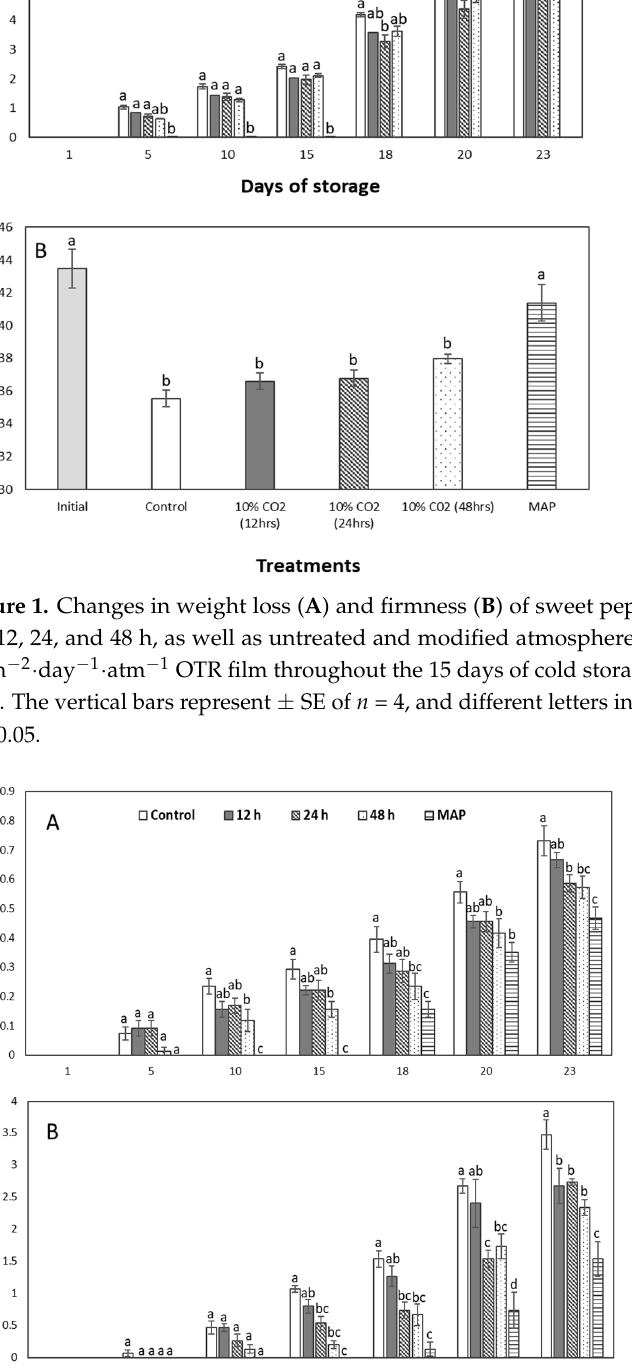
Figure 3. Image of sweet pepper fruits pretreated with 10% CO 2 for 12, 24, and 48 h, as well as untreated and modified atmosphere packaging (MAP) with 50,000 cc ∙ m − 2 ∙ day − 1 ∙ atm − 1 OTR film on the 15th day of cold storage ( A ) and on the last day ( B ). 2.3. Gas Production Rates and Concentration in Modified Atmosphere Packaging (MAP) The fruit’s respiration and ethylene production rates are shown in Tables 1 and 2. Immediately after the CO 2 treatment, fruit respiration was noticed to increase based on